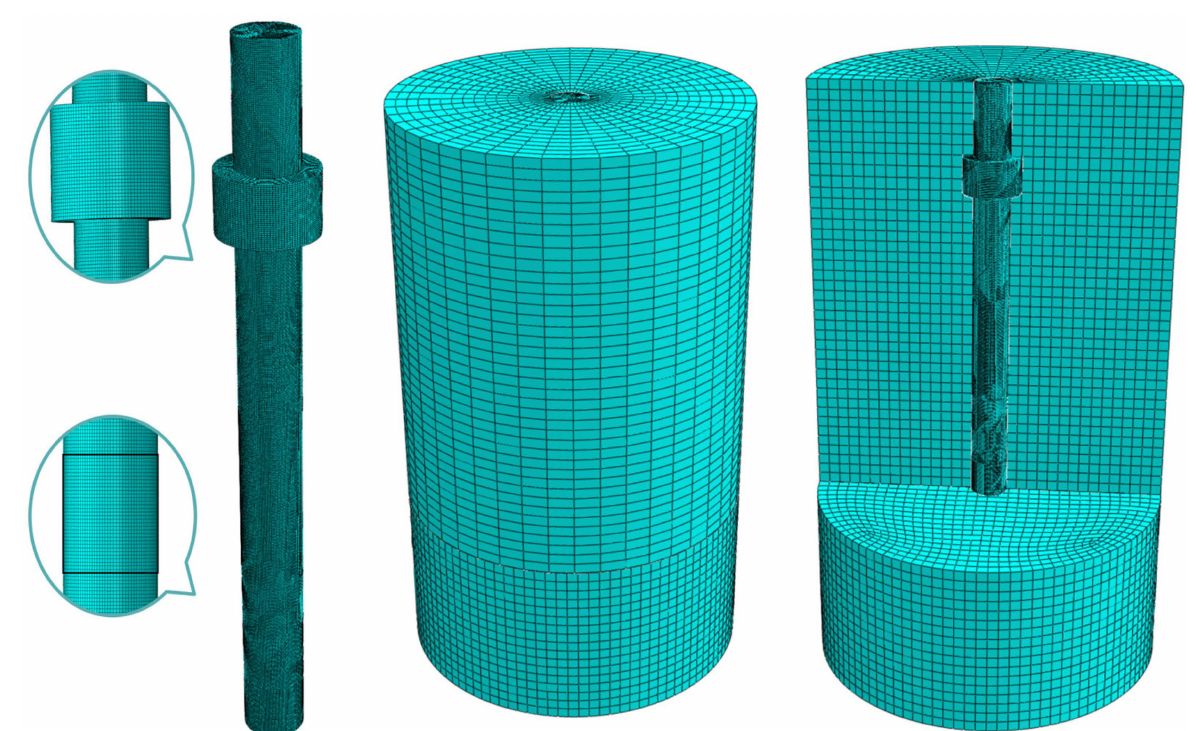
Figure 2. Finite element mesh of pile and